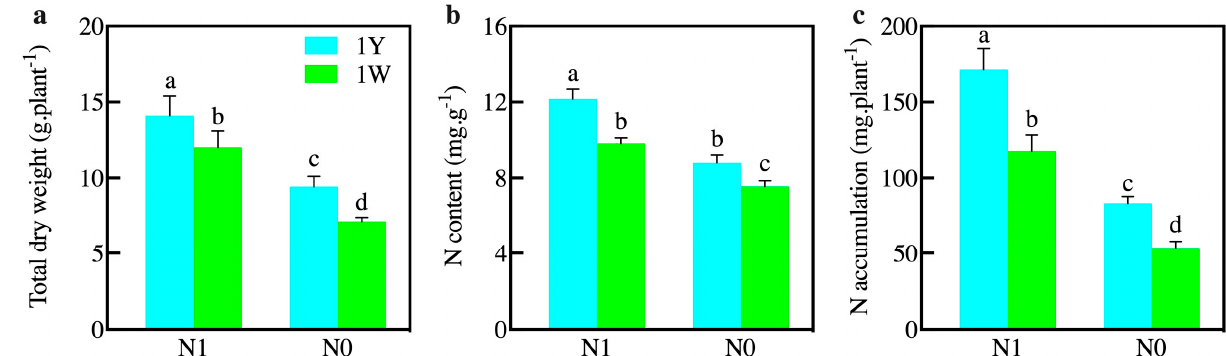
Figure 1. Plant growth performance of wheat NILs at the anthesis stage under different nitrogen treatments. ( a ) Total dry weight; ( b ) N content; ( c ) N accumulation; 1Y and 1W represent the high-NUE and low-NUE wheat, respectively; N1 and N0 represent the normal nitrogen and low nitrogen fertilizer application level, respectively. The results shown are the means +/ − SD, different lowercase letters denote a statistically significant difference ( p < 0.05).